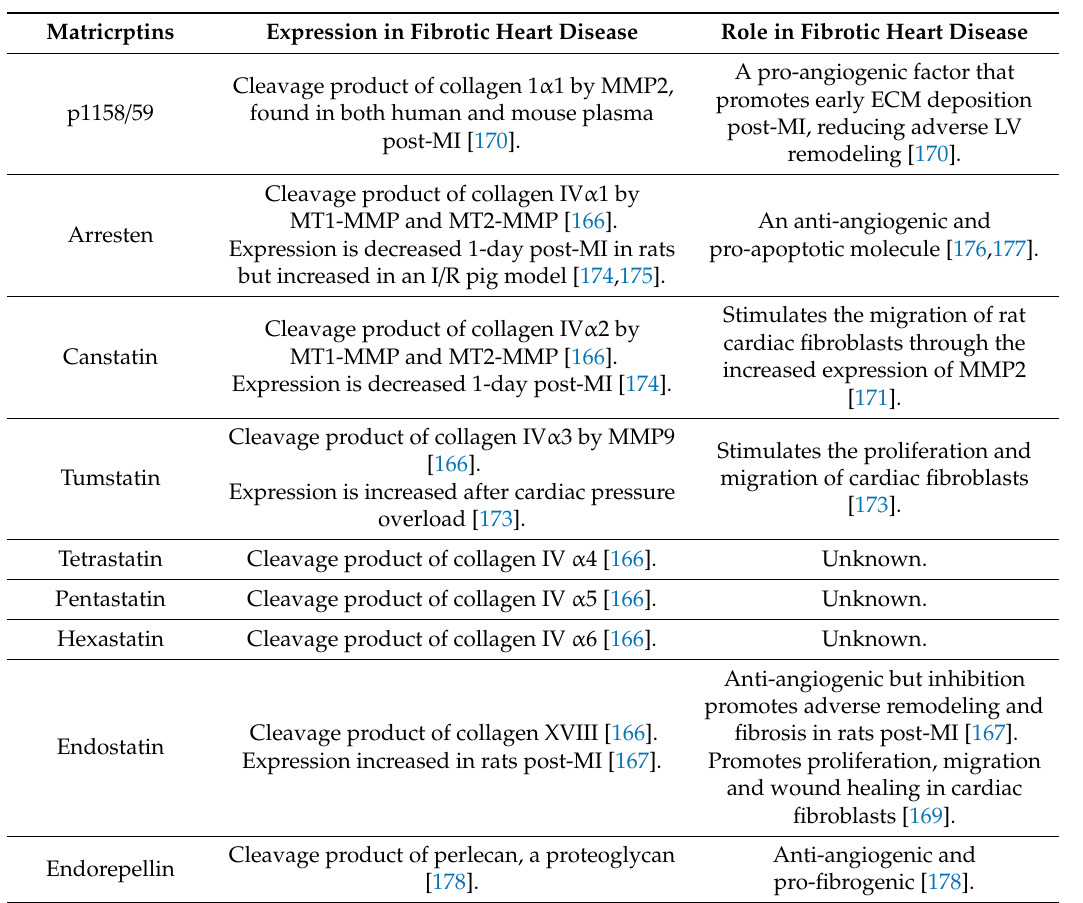
Table 3. List of Matricryptins with reported contribution to myocardial